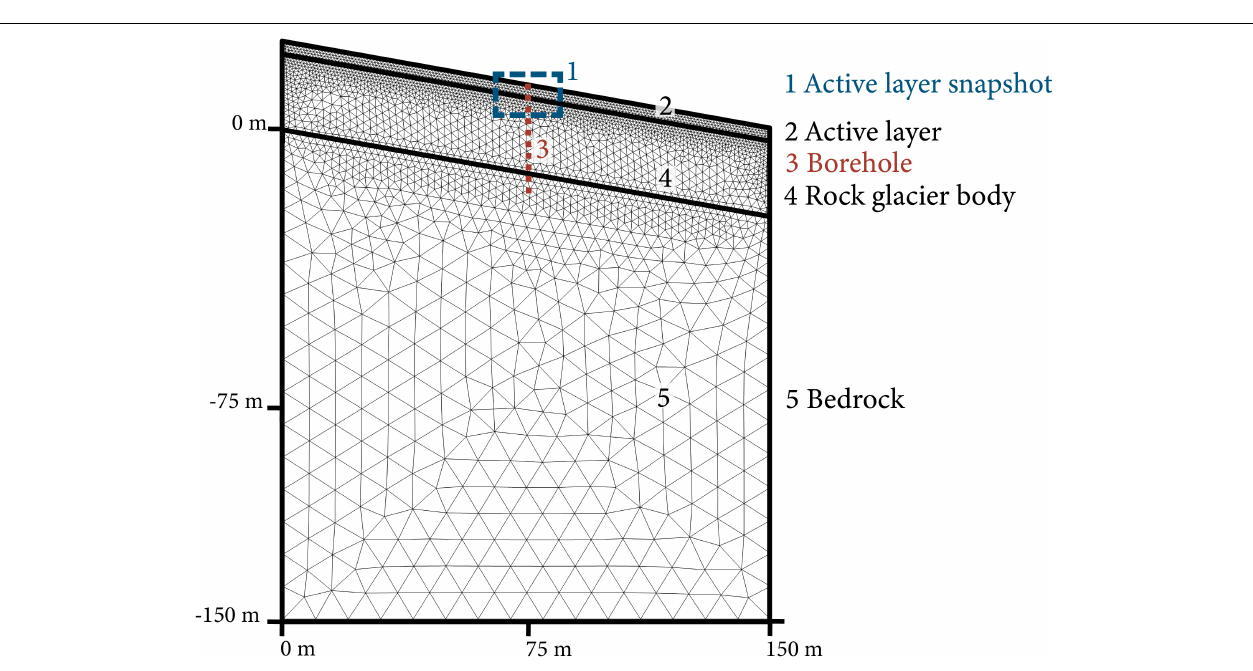
FIGURE 2 | Geometry with the different domains (black) and the meshing. The site respective parameters are given in Table 1 . The red dotted line (3) indicates the position of the virtual borehole and the blue dashed rectangle (1) the location of the active layer snapshots in the results section ( Figures 6 , 7 ).